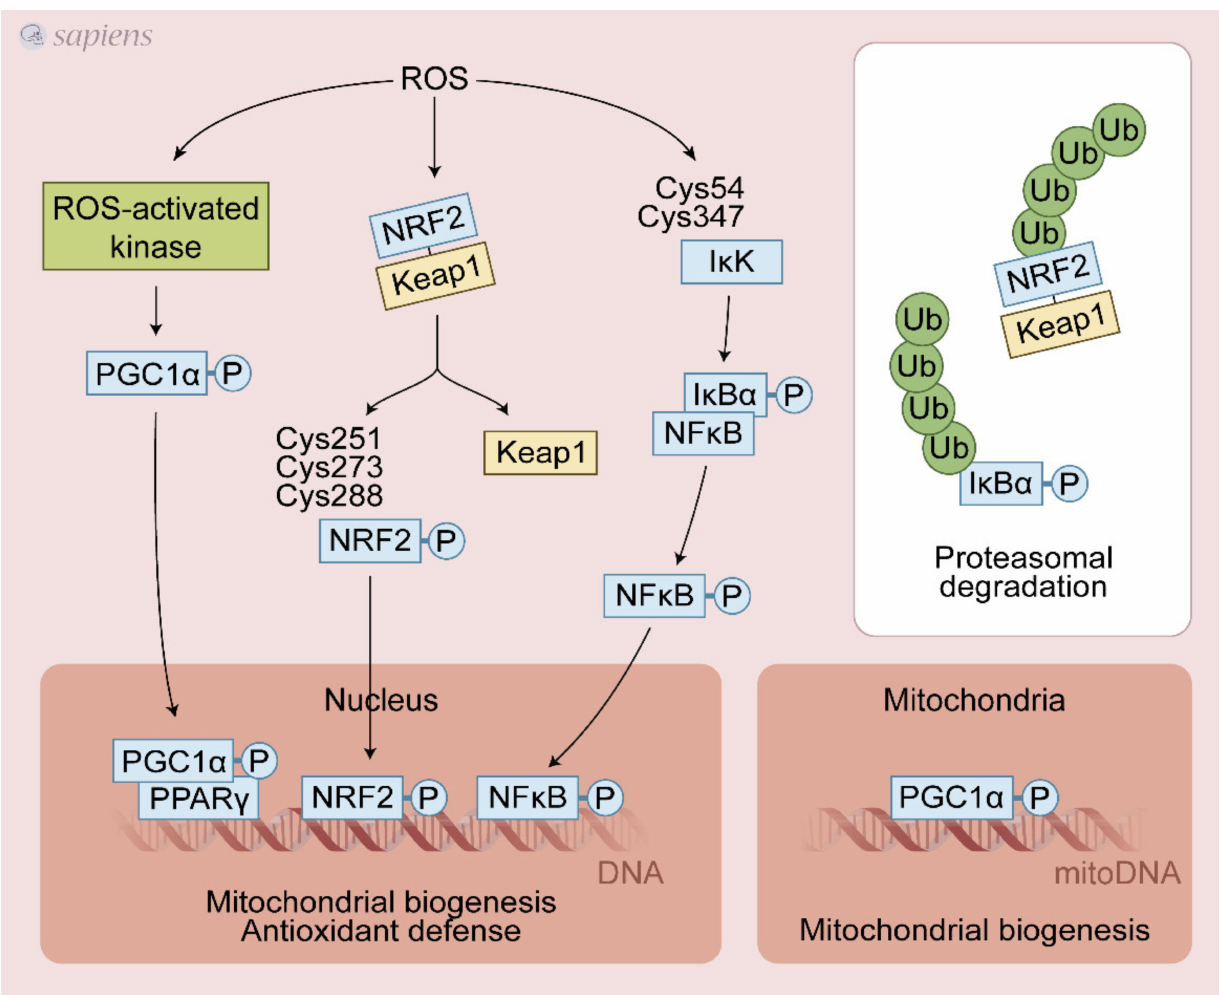
Figure 3. Exercise-generated ROS activate redox-sensitive transcription factors. ROS lead to various post-translational mod- ifications that increase upstream pathways that promote PGC-1 α activation (e.g., P38 MAPK, CaMK, AMPK). NRF2/Keap1 complex dissociation is stimulated by ROS, avoiding its proteasomal degradation thereby sustaining the NRF2 signaling. Additionally, ROS can directly activate NRF2 through cysteines modifications. NF-kB cysteines oxidation activates IkK that phosphorylates IkB α , leading to its dissociation and activation of NF-kB signaling. These redox-sensitive transcription factors regulate mitochondrial biogenesis and antioxidant defense in response to physical